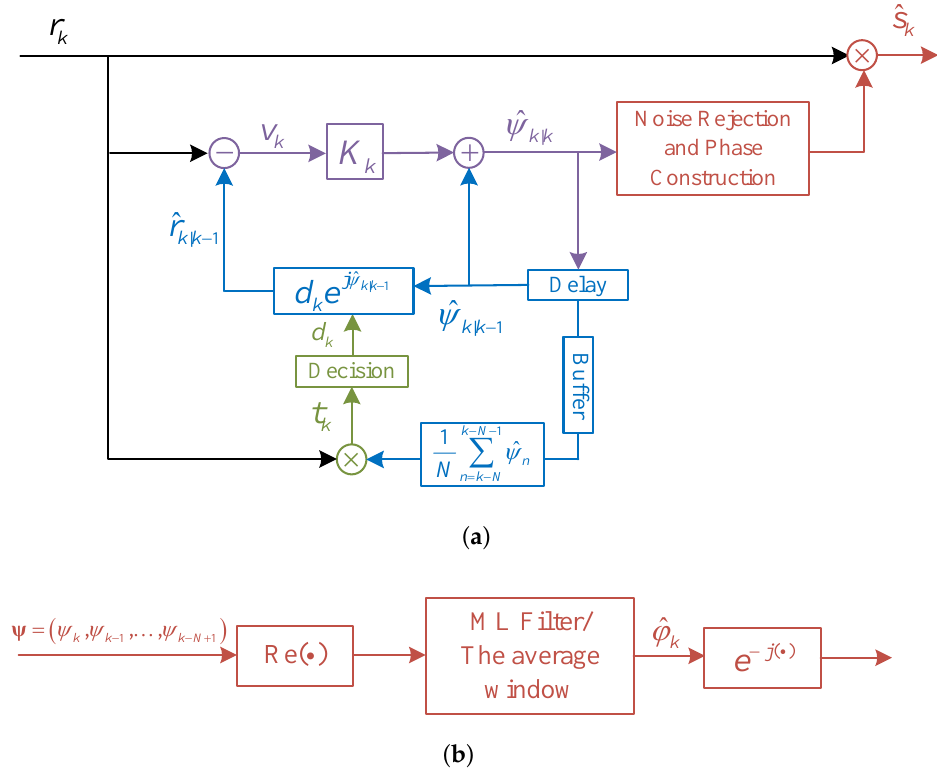
Figure 3. ( a ) Block diagram of proposed EKF-PC algorithm and ( b ) structure diagram of noise rejection and phase reconstruction